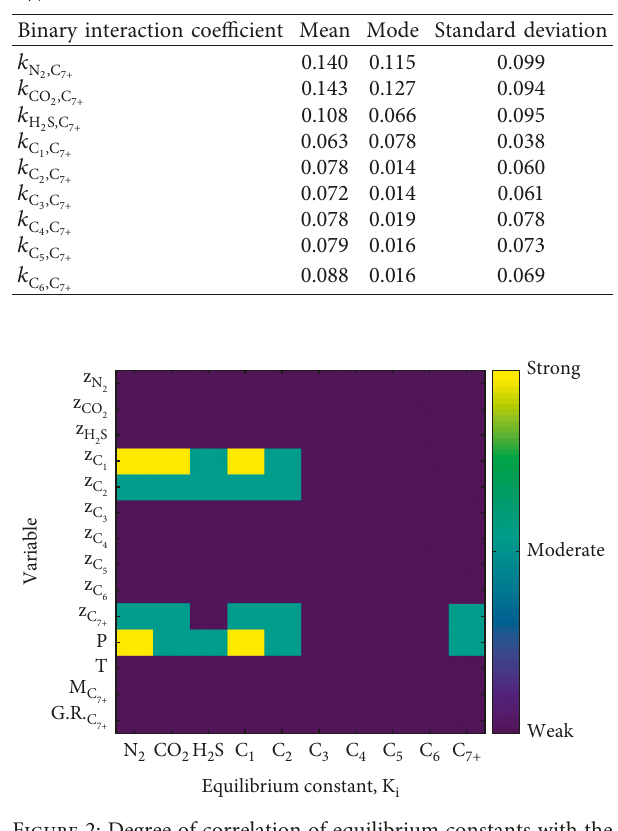
Table 2: Summary of binary interaction coefficients involving the C 7 + fraction.